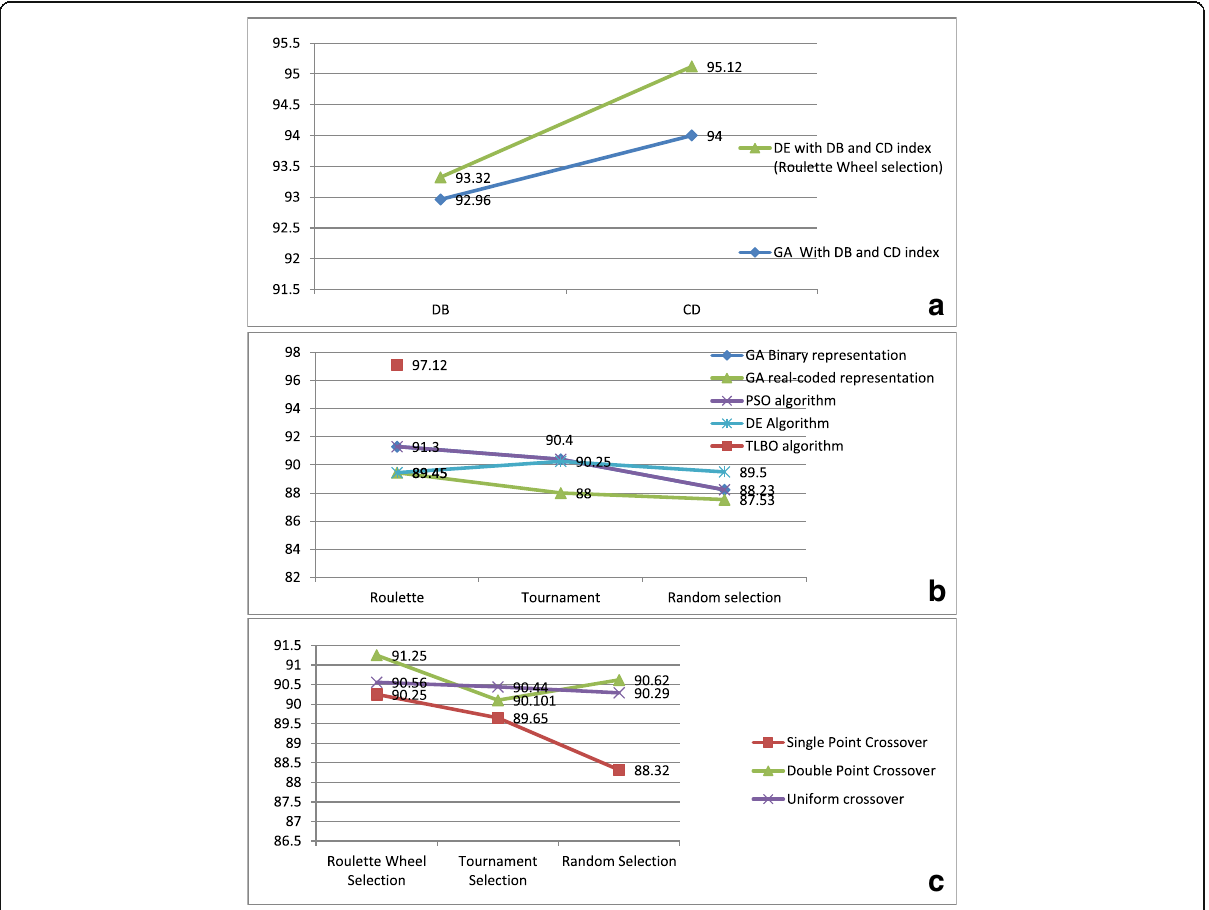
Fig. 3 a Indexing results (K) obtained using GA and DE algorithms with DB and CD indexes. b Indexing results (K) obtained with GA, PSO, DE, and TLBO algorithms. c Indexing results (K) obtained using GA algorithm with different crossover